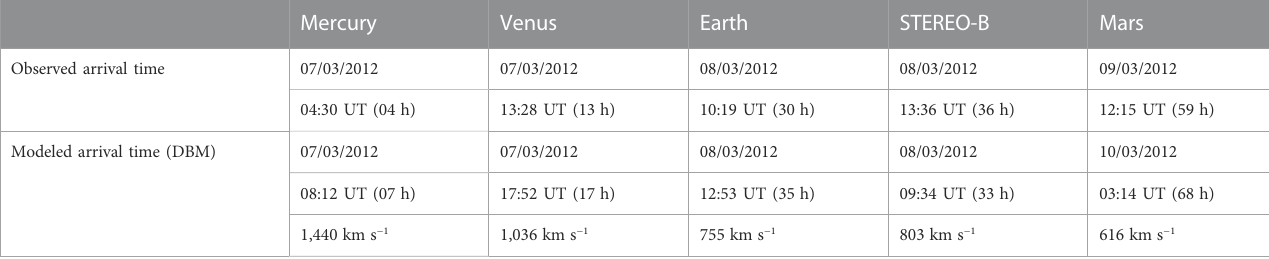
TABLE 2 Observed and calculated time of shock/CME arrival at various locations, compared with the arrival time and velocity estimated by the DBM. Mercury Venus